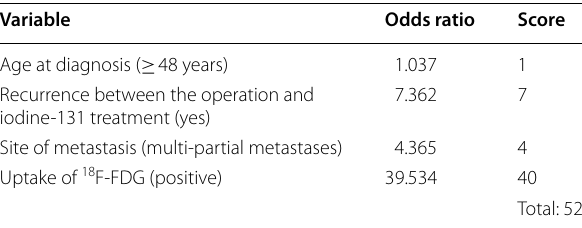
Table 3 Scoring system for predicting the radioiodine refractory differentiated thyroid cancer